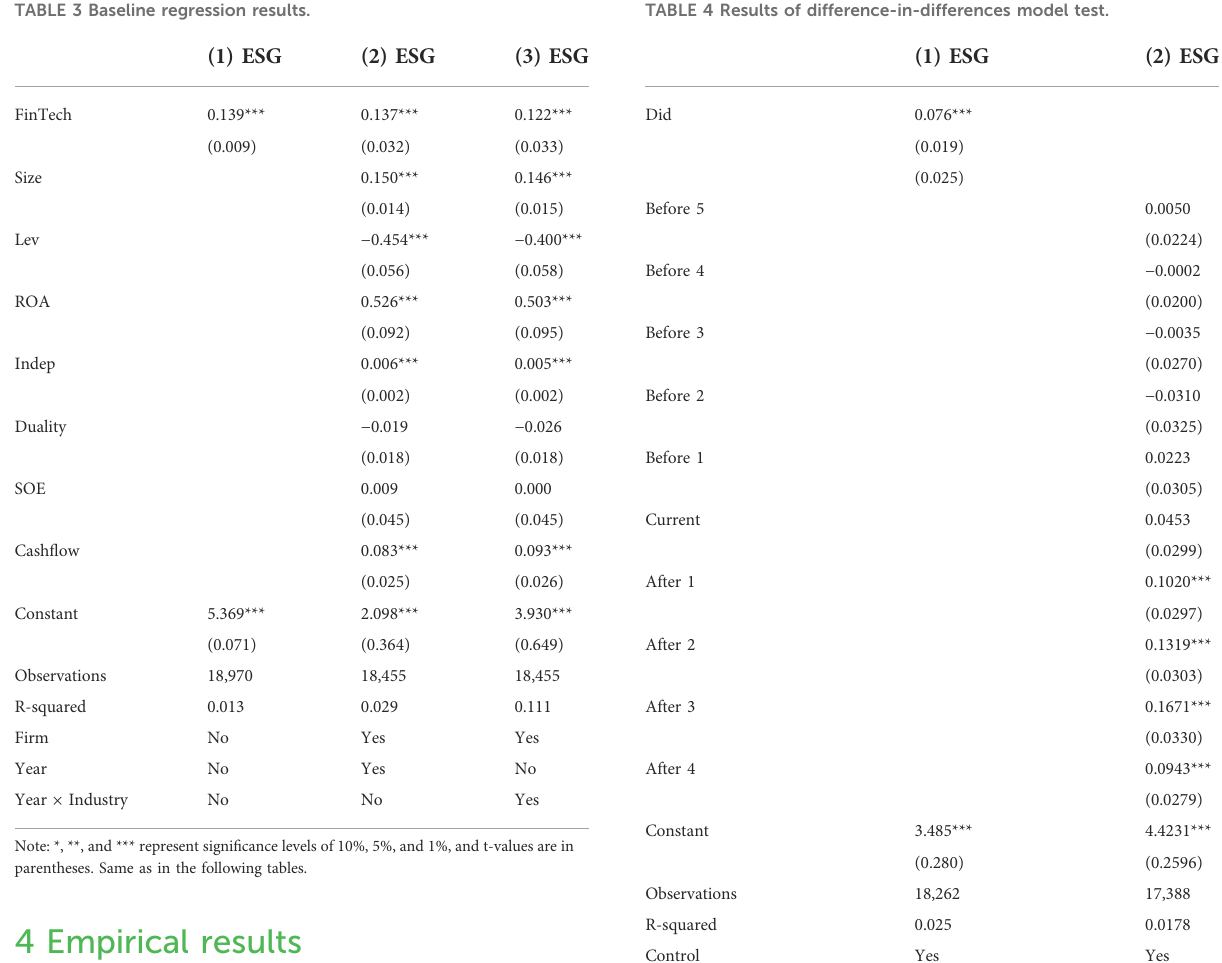
TABLE 3 Baseline regression results. TABLE 4 Results of difference-in-differences model